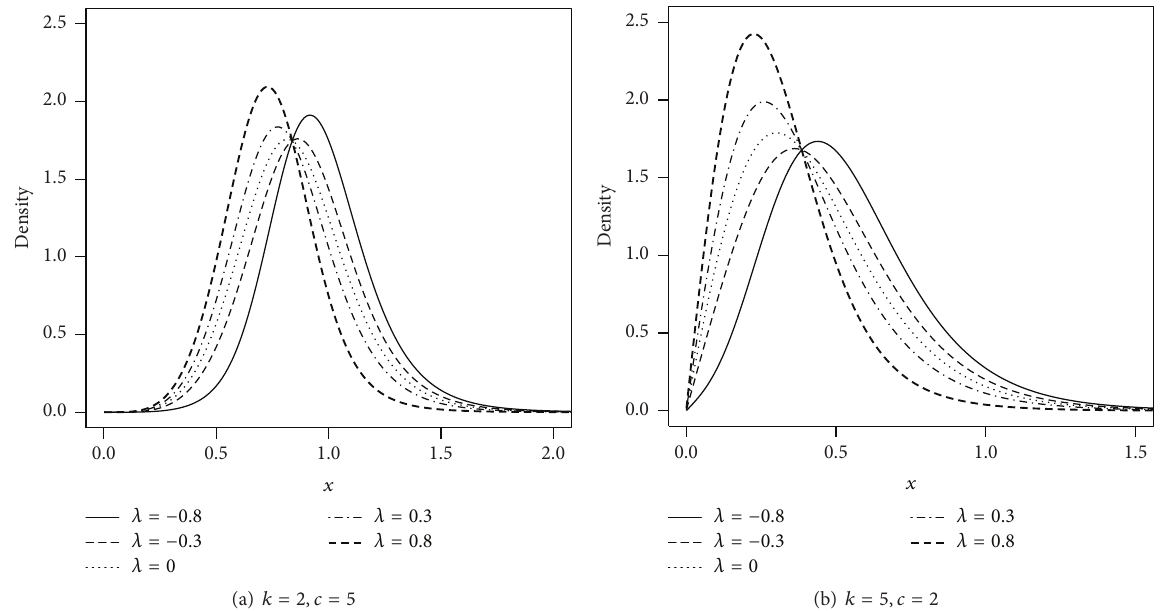
Figure 1: Plots of the TBXII density function for some parameter